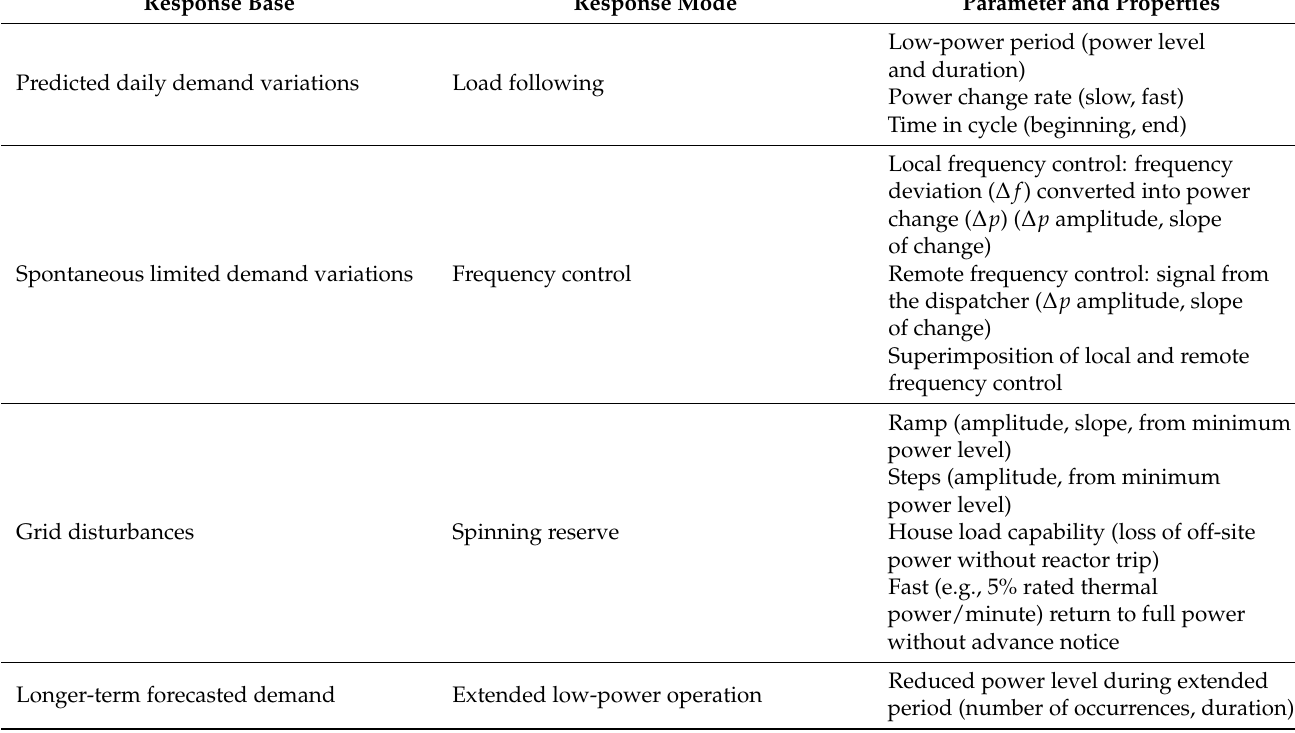
Table 3. Design Philosophy for Flexible Operation in German Light Water Reactor.